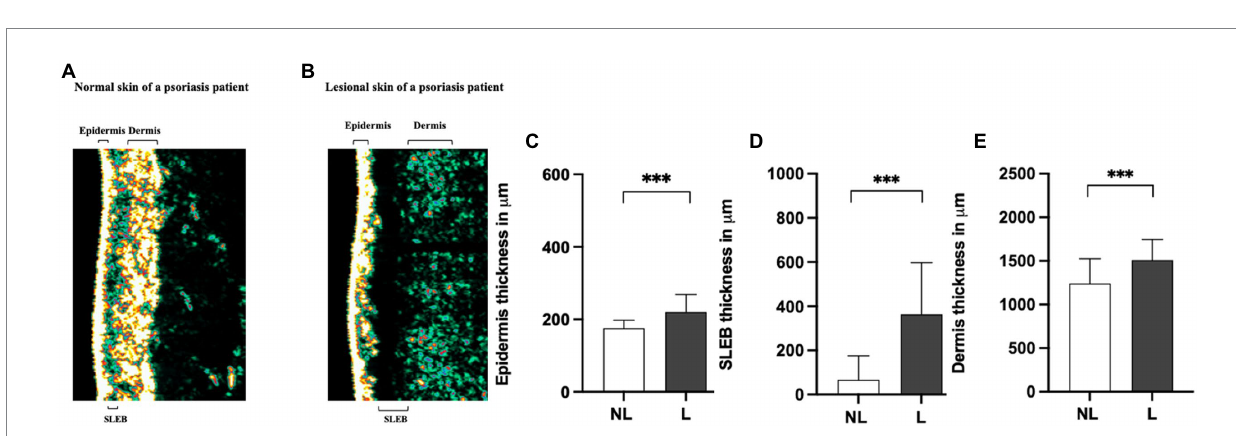
FIGURE 2 Comparison of sonography data of non-lesional and lesional skin of psoriasis patients. A representative image of the thickness of the epidermis, SLEB, and dermis in non-lesional (panel A ) and lesional skin (panel B ) of a psoriasis patient measured by ultrasound. 20-MHz ultrasound image of the non- lesional (panel A ) and lesional skin area (panel B ) of the same psoriasis patient is presented. The positions of the epidermis, SLEB, and dermis are indicated in the image. The apparent average epidermal thickness (panel C ), SLEB thickness (panel D ), and dermis thickness (panel E ) analyzed from non-lesional skin (NL; white bars) and lesional skin (L; black bars) have been blotted. The ultrasound measurements are performed at the exact lesion and healthy apparent skin of the psoriasis patient where the FibroTx TAP measurements were performed and local clinical scores by the physician were stated. Y -axis: Average thickness of the epidermis, SLEB, and dermis, respectively, in μ m. X -axis: sampling site. Error bars on graphs present the standard deviations from the average of combined measurements of the patients ( N = 30). Statistical significance was determined with paired sample Wilcoxon signed-rank test (* p < 0.05, ** p < 0.01, *** p <